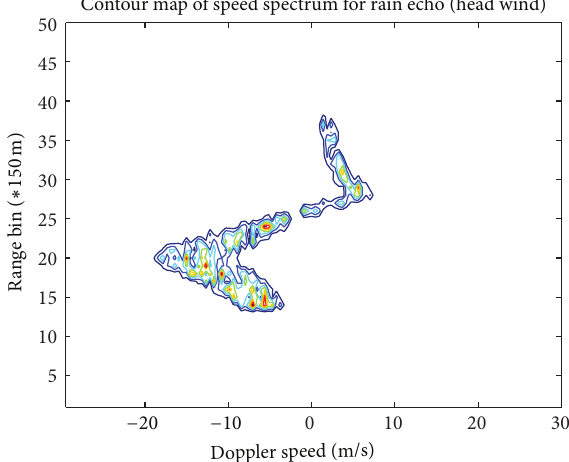
Figure 8: Rain Echo Spectrum Distribution of asymmetric wind field for head wind (Contour Map).